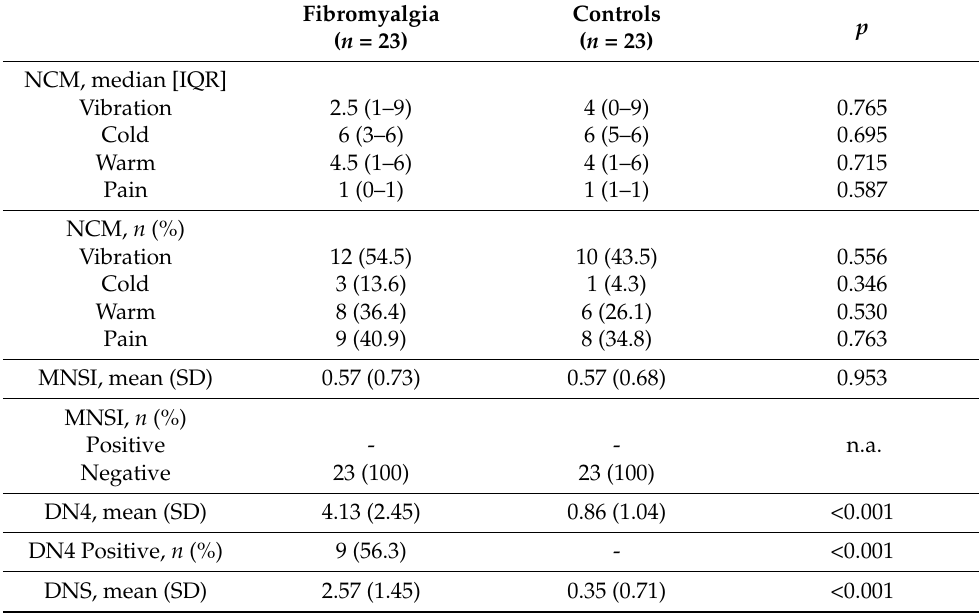
Table 2. Diabetic Peripheral Neuropathy (DPN) tests.